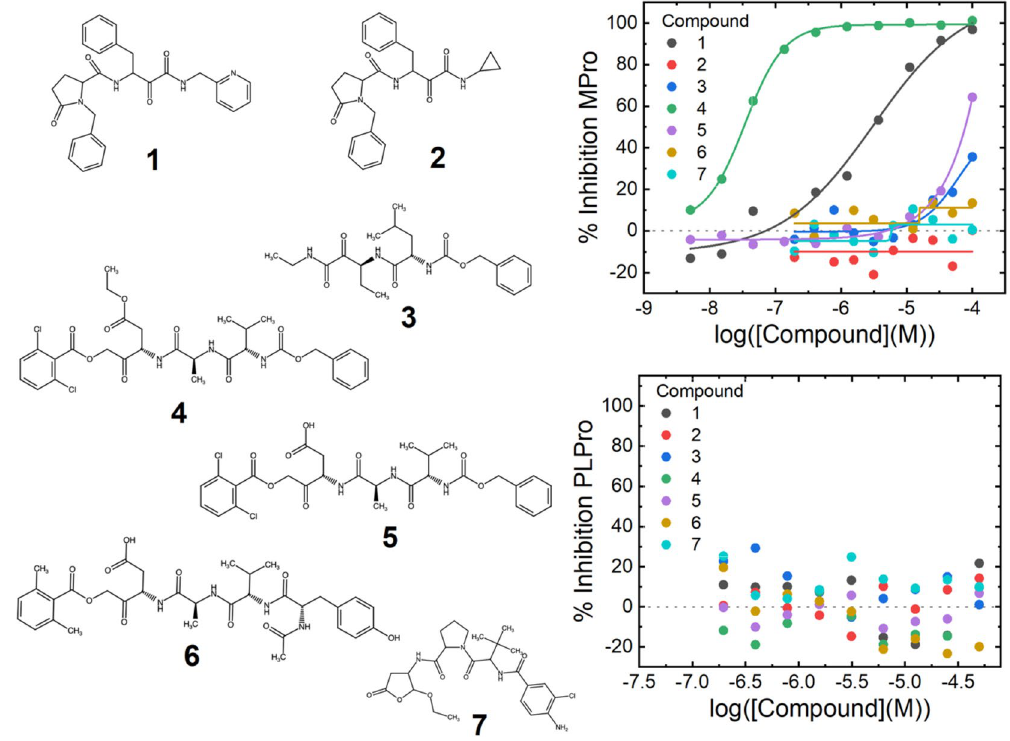
Figure 3. Potent inhibitors of SARS-CoV-2 M pro . Structures of the compounds tested against M pro are shown to the left of the graphs. Compounds 1 – 3 are calpain inhibitors and 4 – 7 are caspase-1 inhibitors. 1 is a pyridine analogue of ABT-957 ( 2 ), 4 is the ester prodrug SDZ 224015 with 5 Caspase-1 active acid version of 4 . The upper graph shows titrations of the compounds plotted against inhibition of M pro , and the lower graph shows the same compounds against PL pro . Data are singlicate and representative of at least four repeats on separate